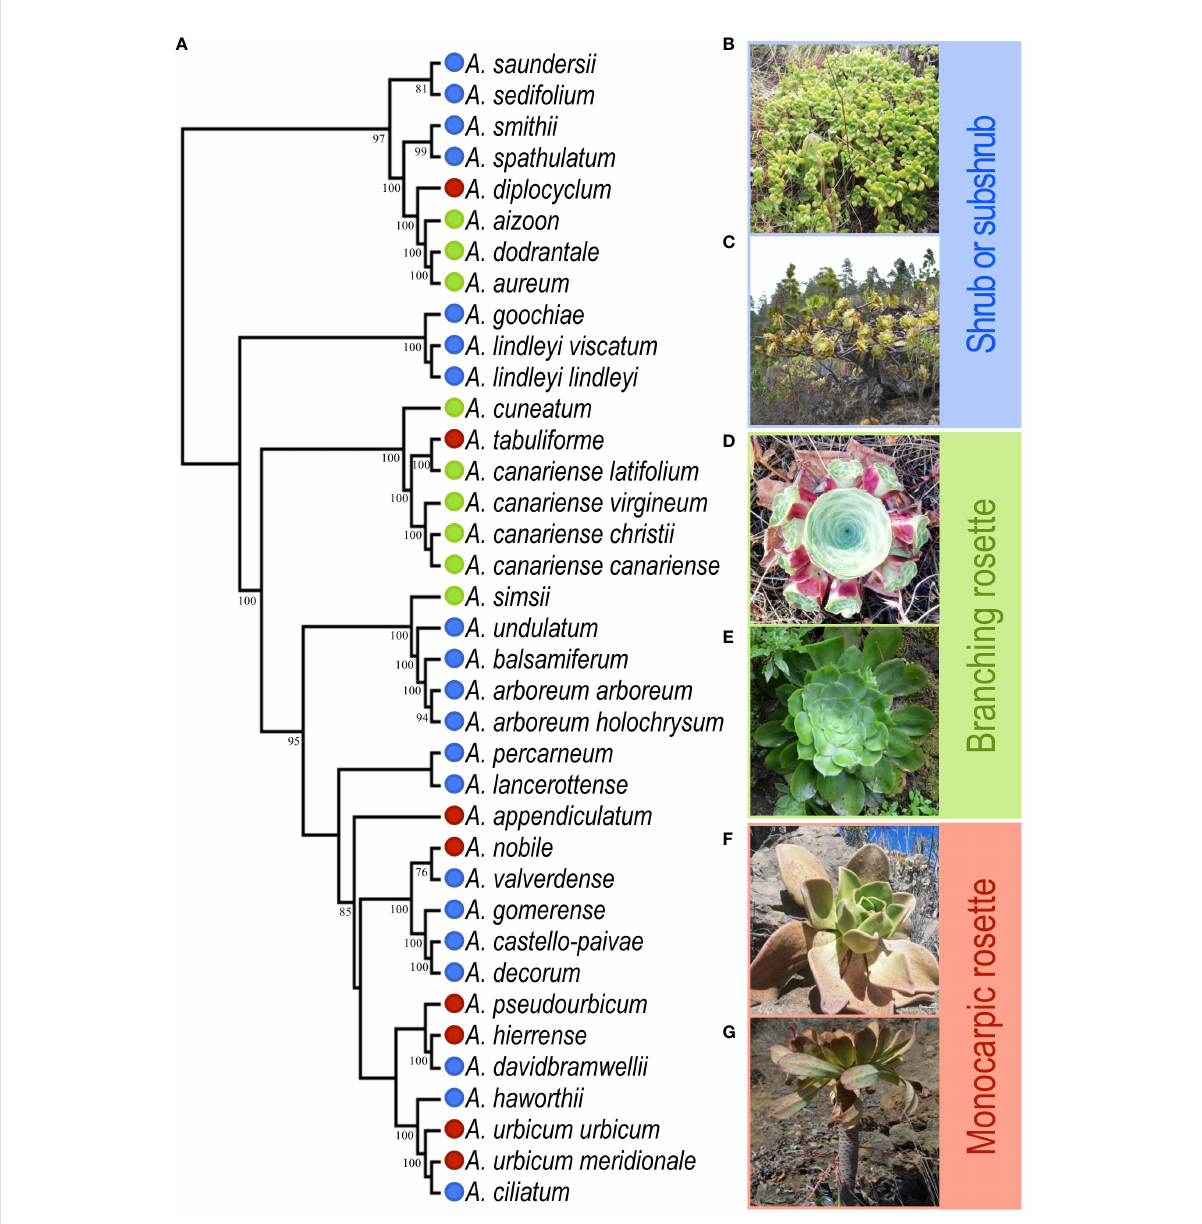
FIGURE 1 Phylogeny and growth form diversity in Aeonium . (A) Adapted phylogeny from Messerschmid et al. (accepted pending revision) to include only the taxa used in this study; numbers below branches indicate bootstrap values >75. Growth forms are represented by colour code: Shrub and subshrub (SS) in blue, ground-branching rosettes (BR) in green and monocarpic rosettes (MR) in red. (B) A. lindleyi ssp. lindleyi ; (C) A. arboreum ssp. holochrysum ; (D) A. aureum ; (E) A. cuneatum ; (F) A. nobile ; (G) A. urbicum ssp. urbicum